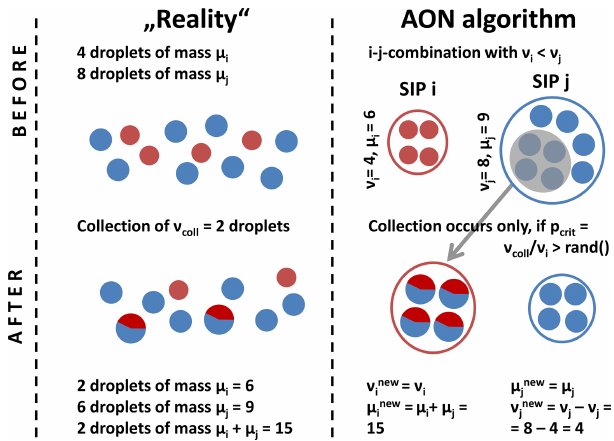
Figure 3. Treatment of a collection between two SIPs in the all-or- nothing (AON) algorithm, partially adopted from Fig. 2 of Unter- strasser et al.